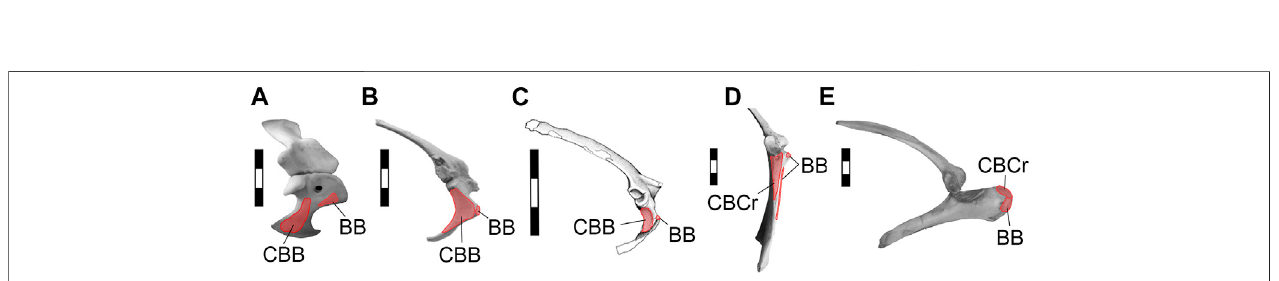
FIGURE7| Selectedscapulocoracoidsfromtherightsideinlateralviews,showingthe mm.bicepsbrachii and coracobrachialis origins. (A) , Caimanlatirostris ; (B) , Archaeopteryx lithographica (London specimen); (C) , Buitreraptor gonzalezorum ; (D) , Rhea americana ; (E) , Vultur gryphus . Abbreviations. BB, m. biceps brachii ; CBB, m. coracobrachialis brevis ; CBCr, m. coracobrachialis cranialis . Light red, muscle origins. Scale bars 3 cm.